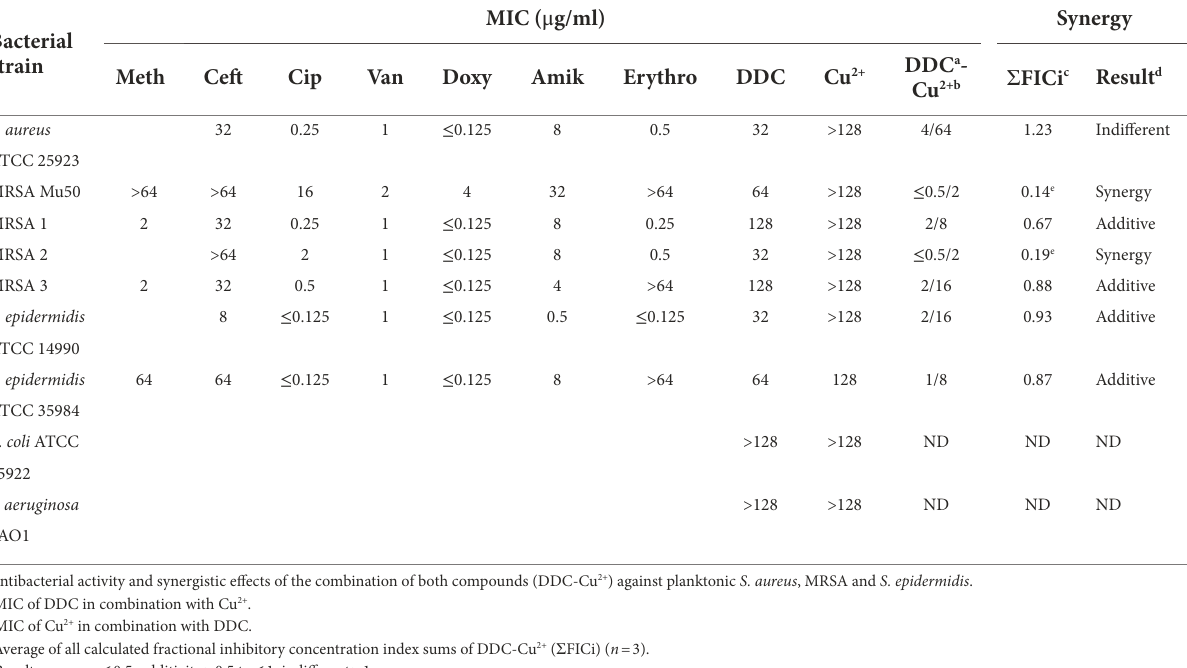
TABLE 2 Minimal inhibitory concentration of the antibiotics methicillin (Meth), ceftazidime (Ceft), ciprofloxacin (Cip), vancomycin (Van), doxycycline (Doxy), amikacin (Amik), erythromycin (Erythro) and the compounds diethyldithiocarbamate (DDC) and Cu 2+ towards planktonic S. aureus , MRSA, S. epidermidis , E. coli and P. aeruginosa.